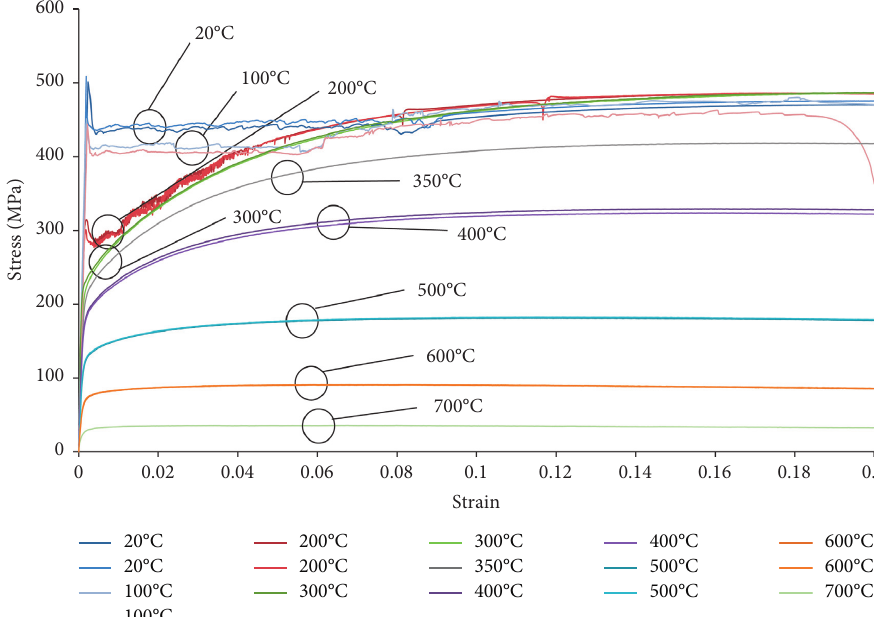
Figure 14: Stress-strain curves of S420 steels at different